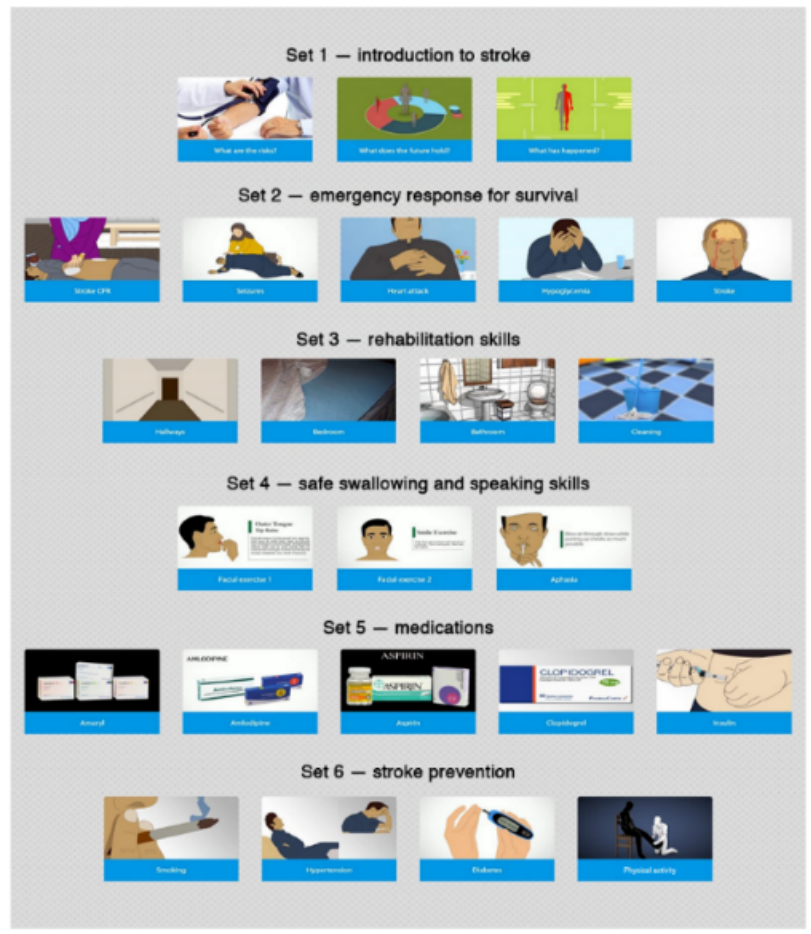
Figure 1. Movies4Stroke collage. CPR: cardiopulmonary